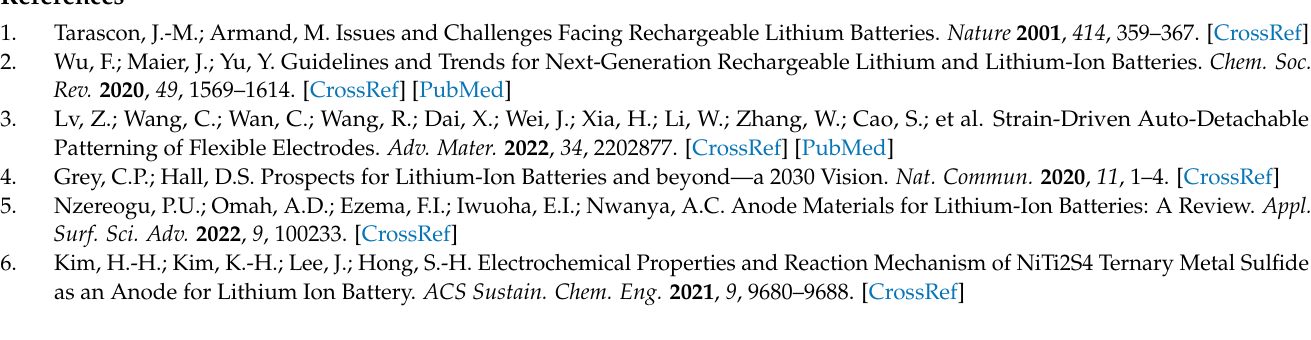
(Figure S5), LiFePO 4 //Li half-cell electrochemistry plots (Figure S6) and comparison of Ternary metal oxides as LIB anode application (Table S1)